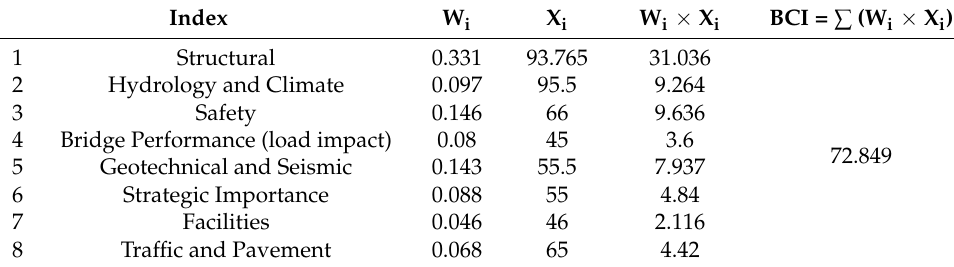
Figure 8. The pavement condition in the bridge No. 1. Table 18. Calculation of BCI in bridge No. 1. Table 18. Calculation of BCI in bridge No.